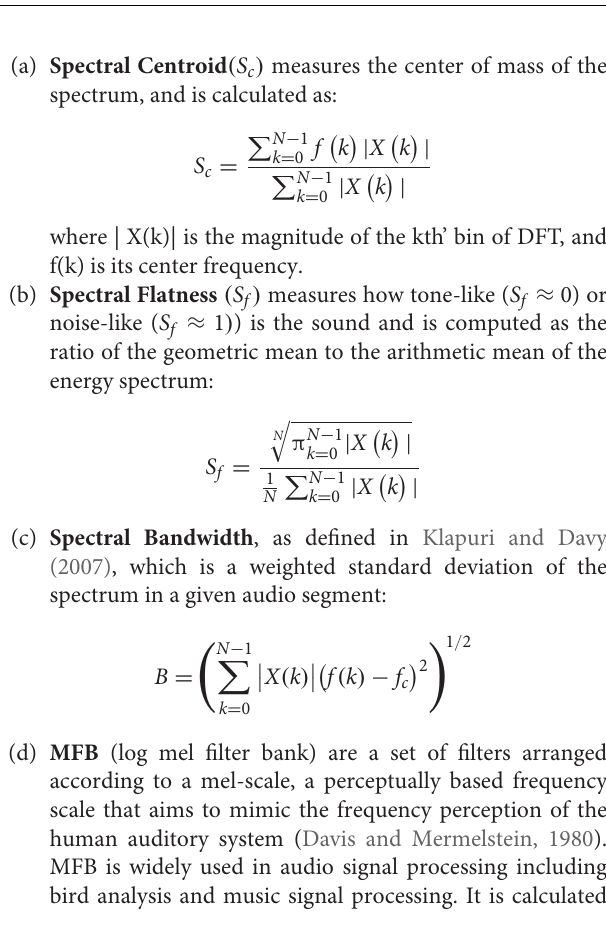
FIGURE 2 | Map of recorders’ locations: three locations in the Hula valley and one in